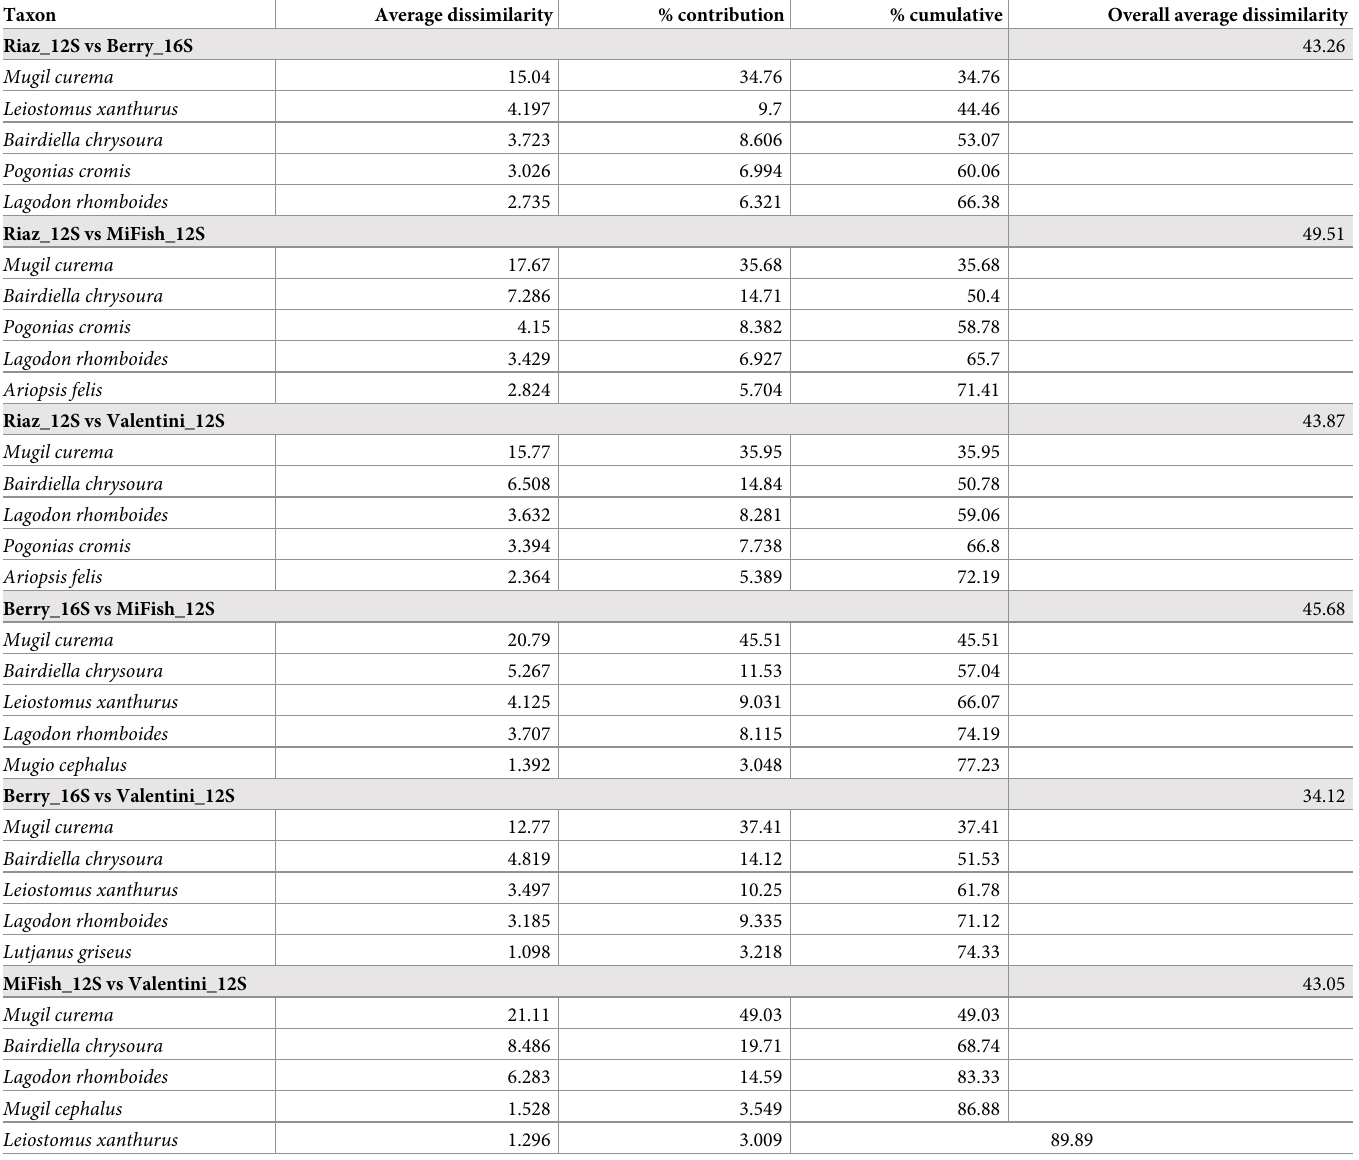
Table 6. Results of SIMPER analysis conducted using the R package